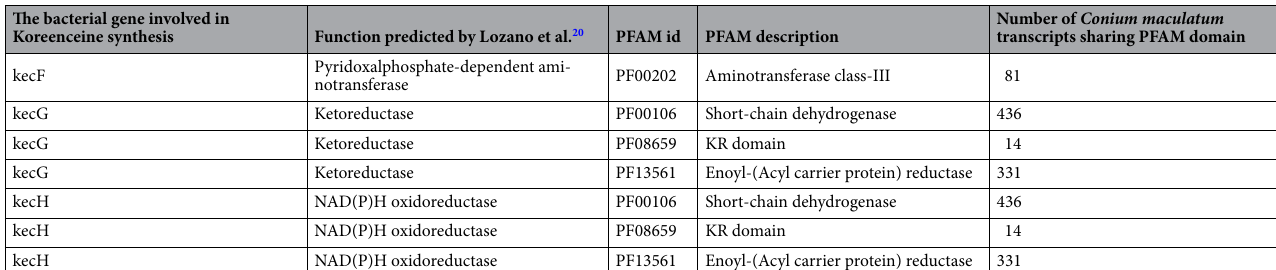
Table 2. The number of transcripts sharing protein family domains with the bacterial koreenceine biosynthesis pathway. As the plant pathway uses PKS type III, unlike the bacterial pathway, we have excluded the PKS genes and included only the polyketide accessory genes and transaminase in our analyses when comparing the bacterial genes with C. maculatum transcripts.